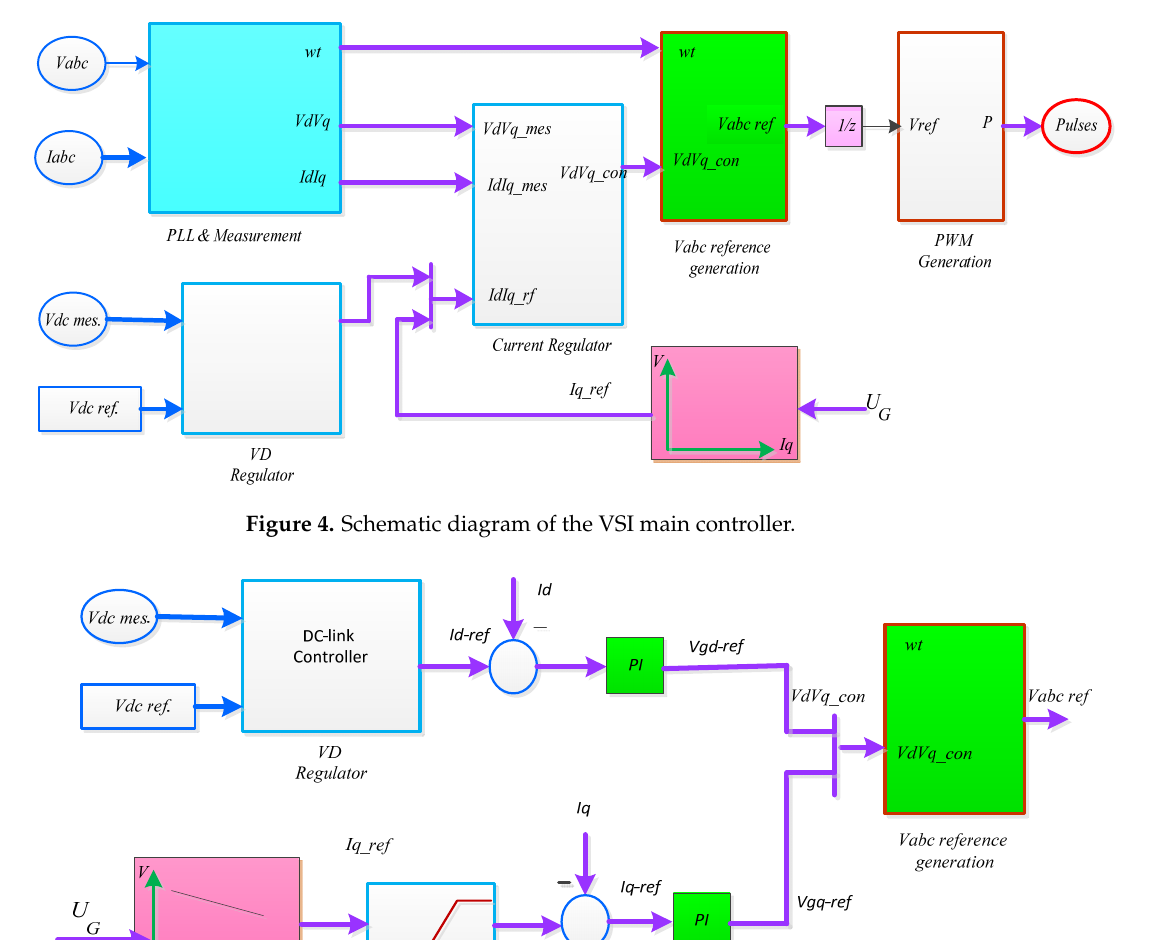
Figure 4. Schematic diagram of the VSI main controller.